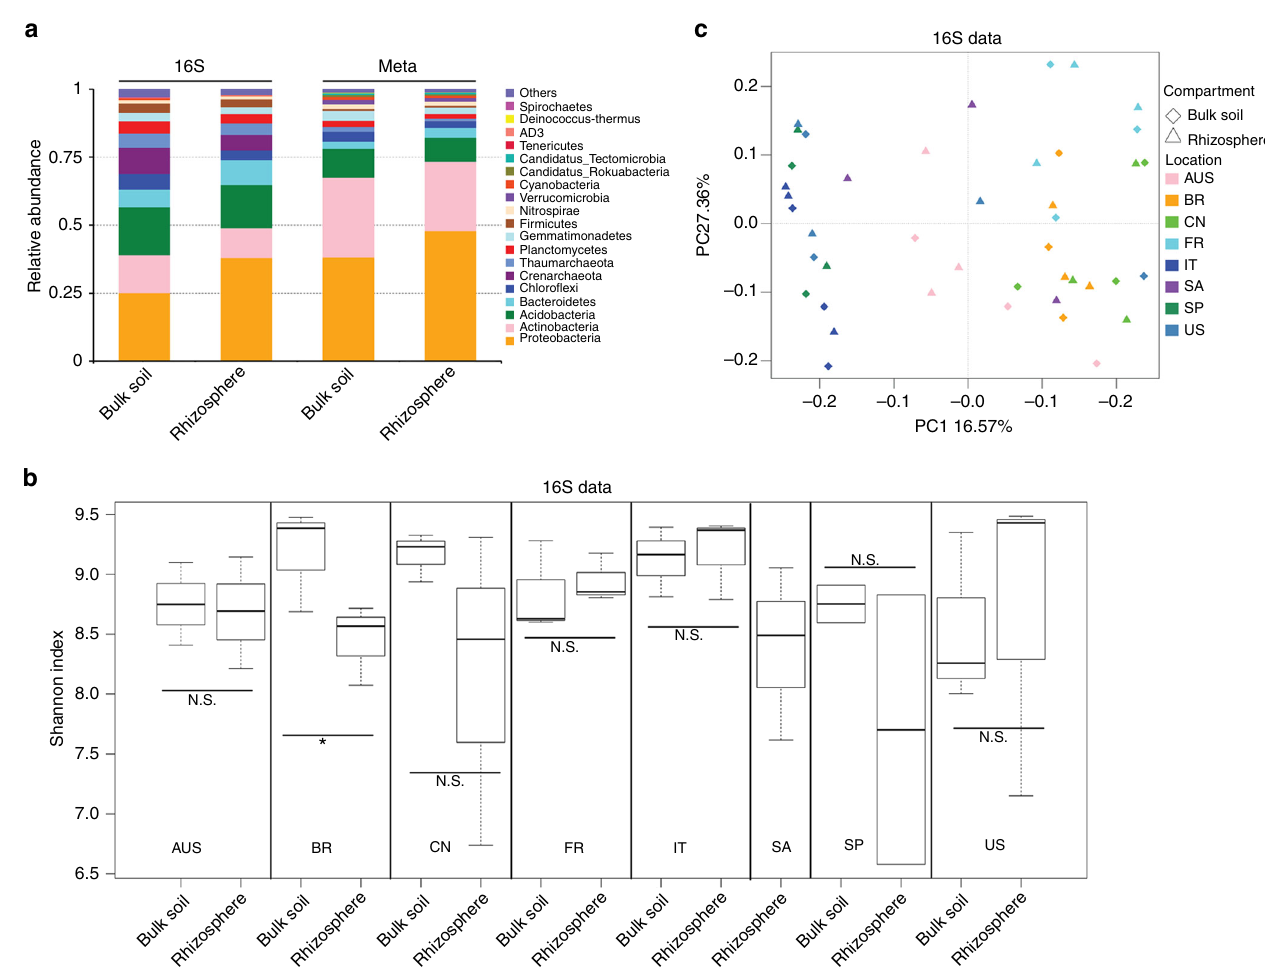
Fig. 2 Taxonomic distribution and diversity comparisons in citrus rhizosphere and bulk soil microbiomes. a Phyla-level distributions in the bulk soil and rhizosphere samples based on 16S amplicon and metagenomic data. b Alpha diversity comparison between the bulk soil and rhizosphere samples from each location based on the Shannon index using the 16S data; N.S. no signi fi cant, * P -value < 0.05. One-sided t -test; center value represents the median of Shannon index. c PCoA based on the unweighted UniFrac distance between the bulk soil and rhizosphere for each location using the 16S data.